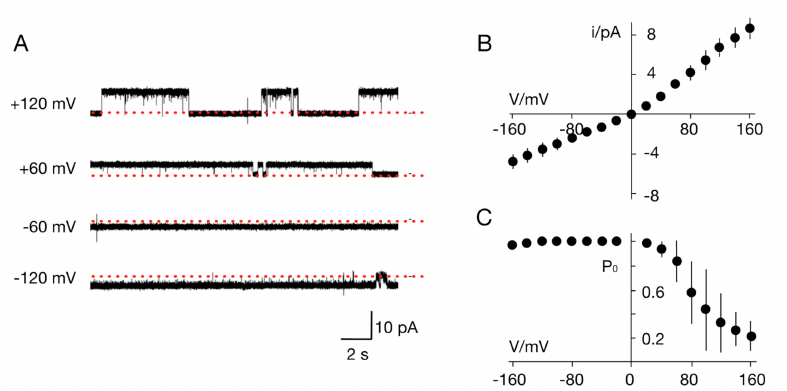
Figure 5. Ktv1 (K + channel from Tetraselmis virus 1) is a functional K + channel. ( A ) Reconstitution of the in vitro-synthesized proteins in planar phosphatidylcholine bilayers generates distinct fluctuations between closed (red line) and open states. The representative recordings in a symmetrical bilayer with 100 mM KCl at voltages between ± 120 mV show frequent opening events at positive voltages and only rare closing events at negative voltages. Open channel current / voltage relation ( B ) and open probability / voltage (P 0 / V) plots ( C ). Data are the mean ( ± S.D.) of 3 independent recordings in same conditions as in